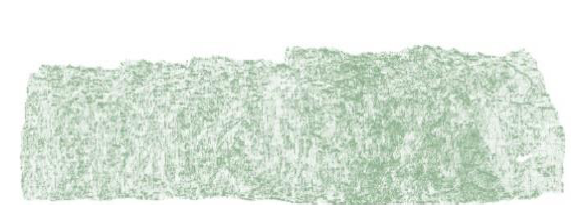
Figure 12. Ground truth, dense point cloud extracted from video data collected by Kinect DK, with a total of 2.56 million points.